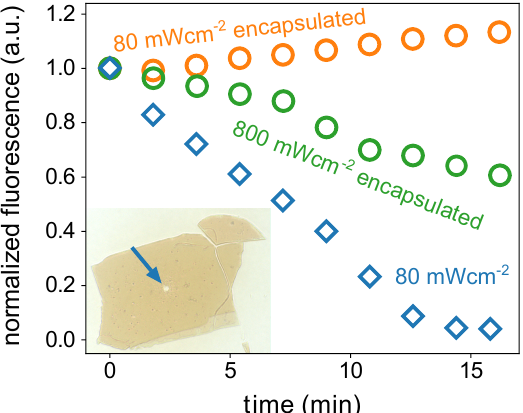
Figure 4. Degradation of PEA 2 PbI 4 2D perovskite flakes under 405 nm laser illumination. The graph shows the normalized (to t = 0) fluorescence intensity of encapsulated (circles) and un-encapsulated (diamonds) perovskite flakes for di ff erent times of laser exposure. The un-encapsulated flake degraded rapidly within only 15 min under 80 mWcm − 2 of laser light. For the same laser intensity, the encapsulated sample did not show any e ff ect of degradation. When increasing the intensity tenfold to 800 mWcm − 2 , also the encapsulated sample started to degrade and decreased to around 60% of its initial brightness after 15 min of exposure. The inset shows an un-encapsulated flake (~70 µ m in width) after 15 min of exposure to 80 mWcm − 2 of laser light. The flake degraded locally and became transparent, where the laser hit the flake (indicated by the arrow).